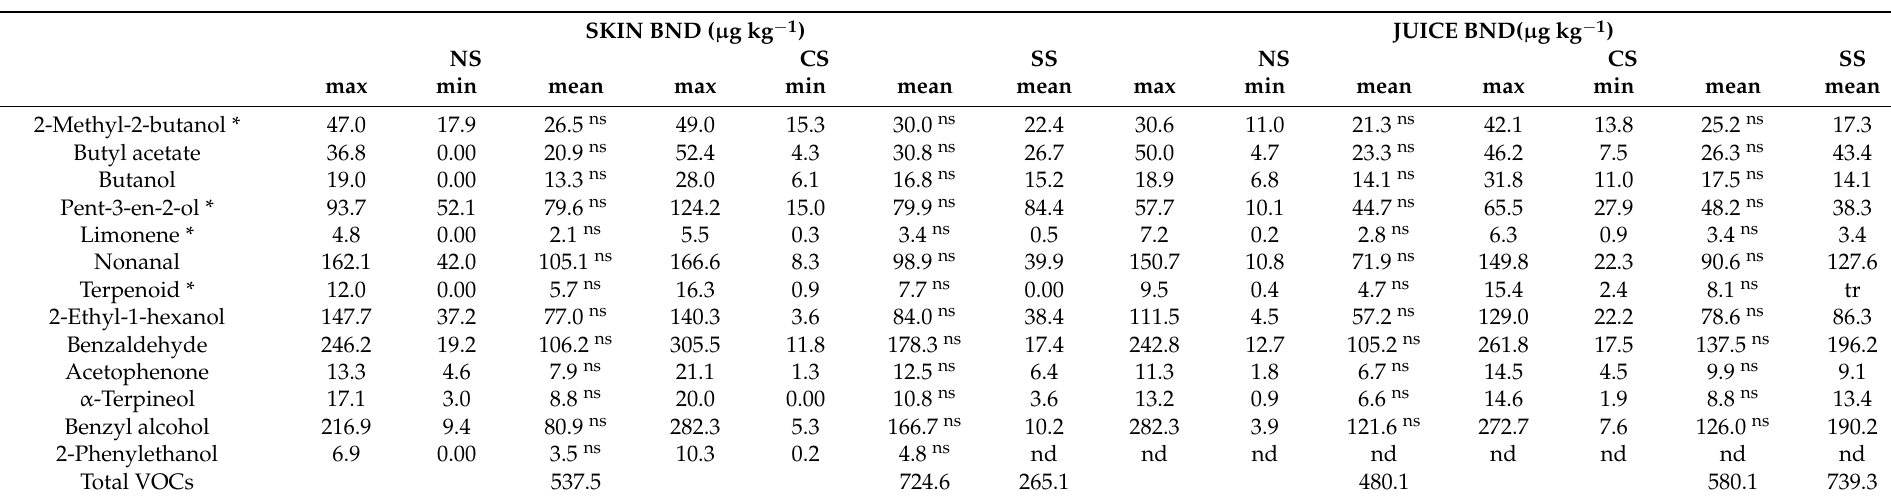
Table 4. Range and average levels of volatile glyco-conjugated aroma compounds in the skin and pulp of Cannonau grapes collected in